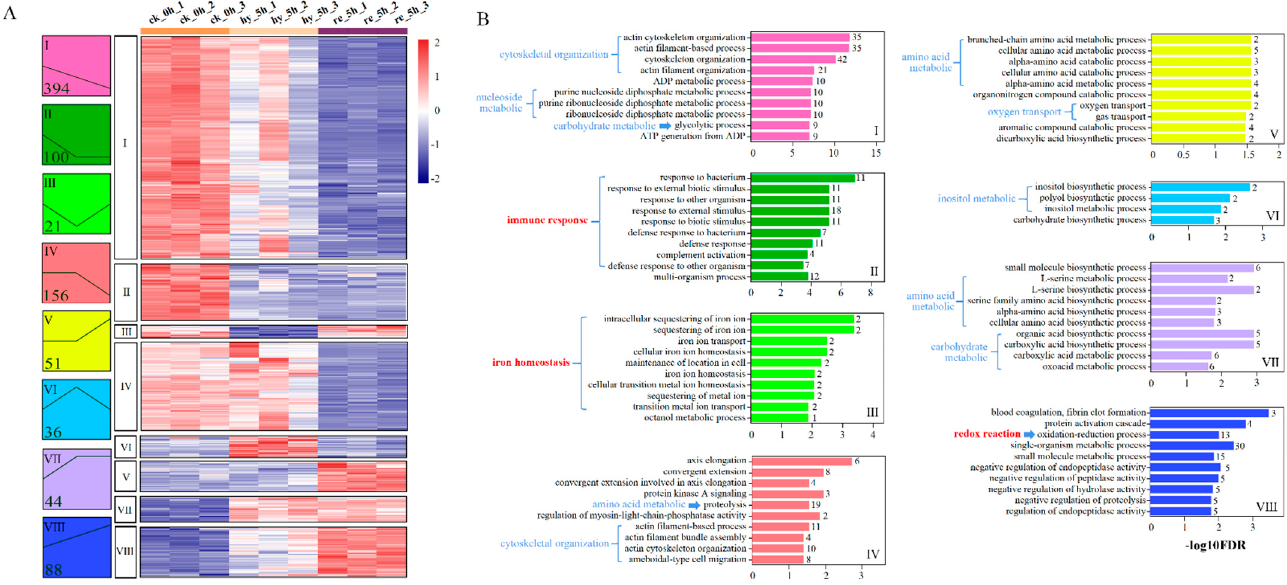
Figure 3. Co-expression modules of 890 DAPs in the liver of juvenile silver carp treated with hypoxia–reoxygenation: ( A ) abundance profiles of the eight statistically significant DAP clusters. Each model abundance profile is represented by a colored box. The boxes show the number of proteins categorized into each module. Heatmaps show the z-scores of the protein levels in the different samples; ( B ) GO biological process terms enriched for each cluster. Top 10 GO terms of each cluster are presented, and the number of DAPs for the terms are shown in the boxes. Ordinate displays log10 FDR (False discovery rate). DAP, differentially abundant protein; GO, Gene Ontology. DAPs in each cluster were classified into diverse functional categories using GO anal- ysis, and the top 10 GO terms of each cluster are presented in Figure 3B (only four GO terms were statistically significant in Cluster 6, p < 0.05). When analyzing the GO terms,